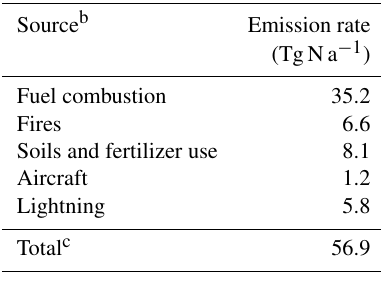
Table 2. Global NO x emissions in 2015 a . Source b